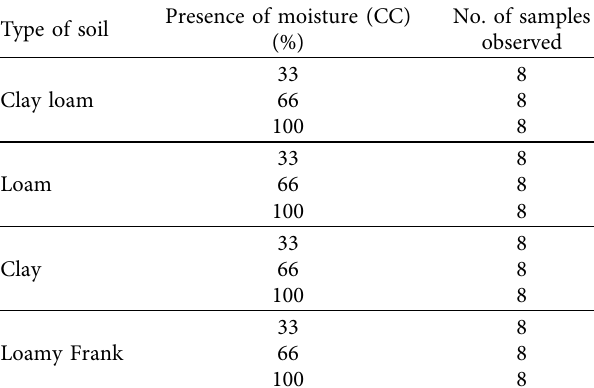
Table 3: Details of experiment.